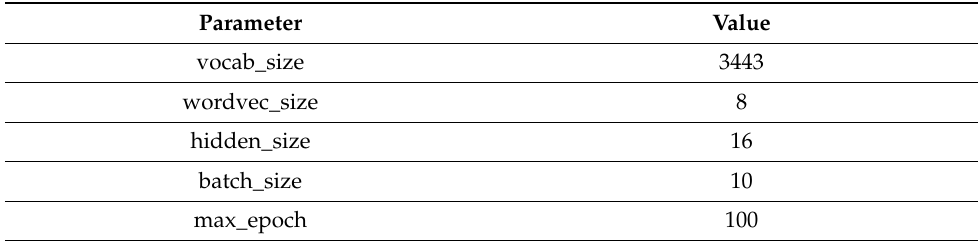
Figure 2. Seq2Seq model to classify each user’s political stance. Table 3. Parameters of the proposed deep learning